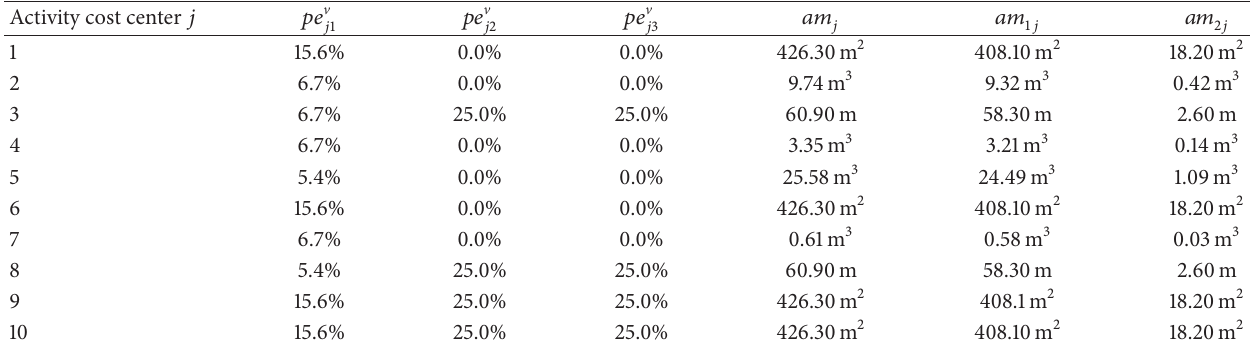
Table 4: Corresponding data of activity cost